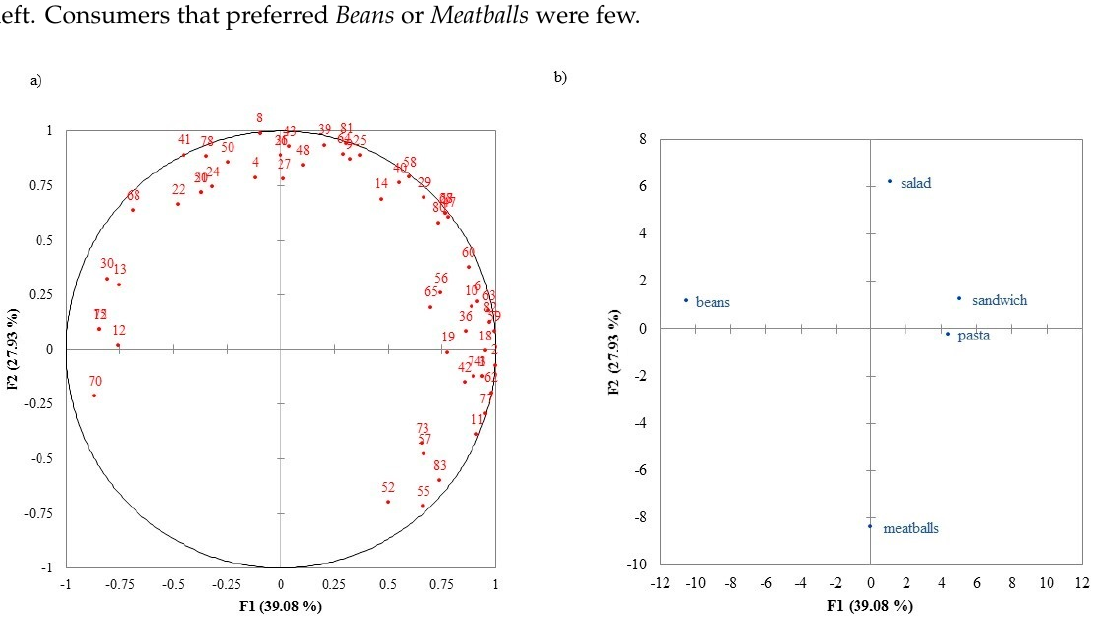
Figure 2. Internal preference map of consumer liking scores of the Meal-Photo condition: ( a ) consumers; ( b ) samples. Foods 2020 , 9 , x FOR PEER REVIEW